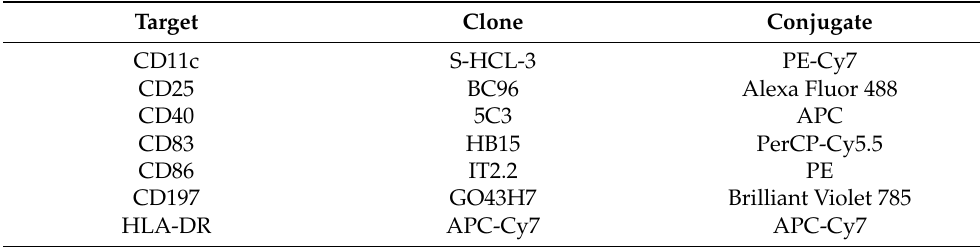
Table 1. Antibodies used in this